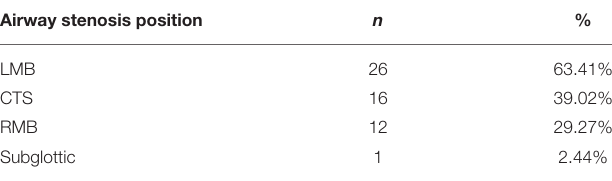
TABLE 2 | The location of airway stenosis in children.